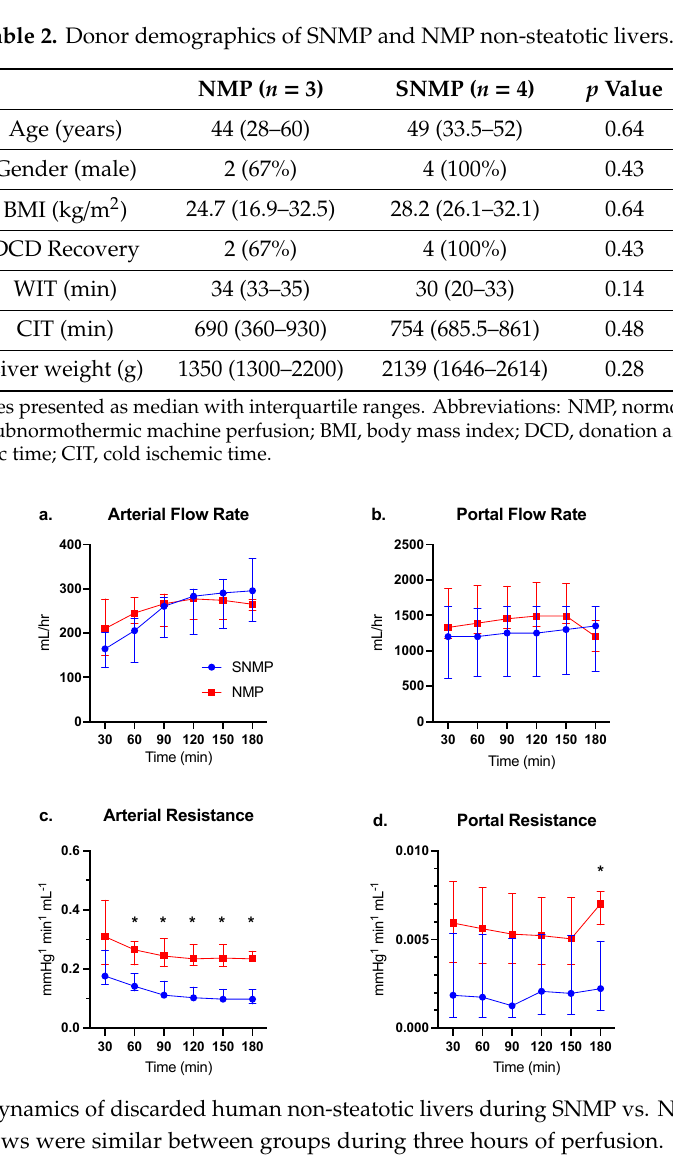
Table 2. Donor demographics of SNMP and NMP non-steatotic livers.